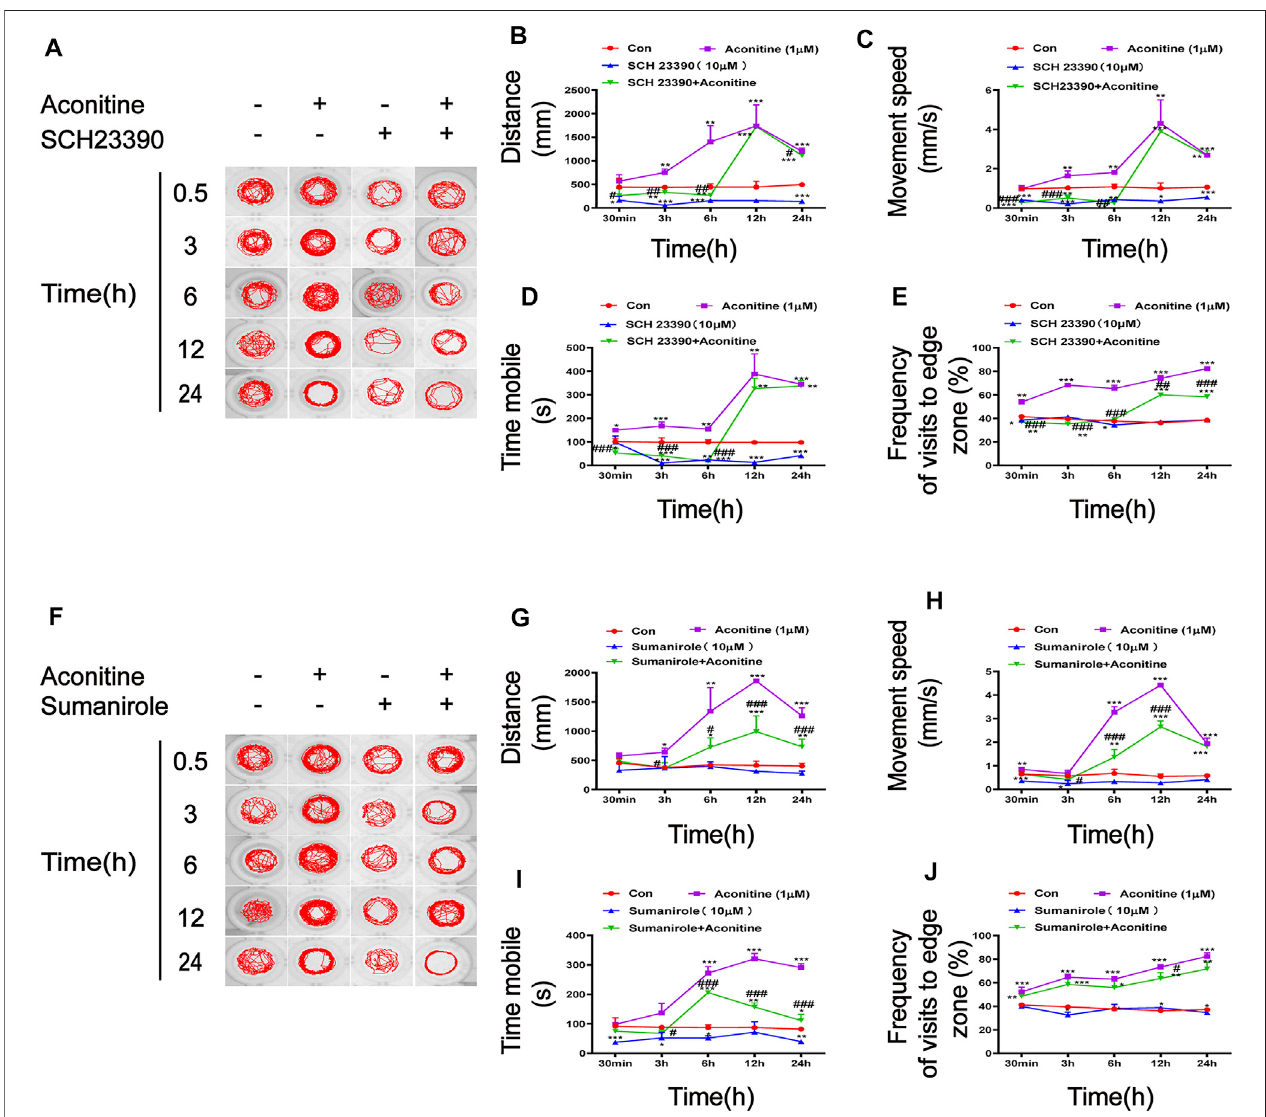
FIGURE6| EffectsofSCH23390andsumaniroleonbehavioralchangesinducedbyaconitineinzebra fi shlarvaes. (A – E) SCH23390inhibitedaconitine-stimulated excitatory behaviors, n = 10. (F – J) Sumanirole suppressed aconitine-induced excitatory behaviors, n = 10. The values are expressed as mean ± SD. * p < 0.05, ** p < 0.01, *** p < 0.001 vs. control groups. # p < 0.05, ## p < 0.01, ### p < 0.001 vs. aconitine-treated groups.